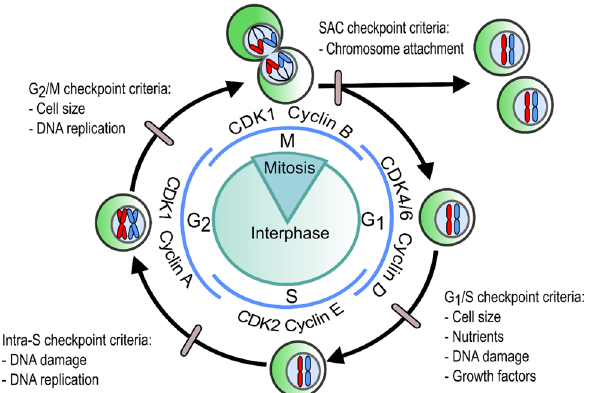
Figure 1. The generalised cell cycle in eumetazoans illustrating the cell-cycle phase and regulatory checkpoints (grey ovals) with their complementary criteria that must be met for the cell cycle to progress through that checkpoint. Blue lines depict the formation of cell-cycle phase associated CDK-cyclin complexes in Homo sapiens . SAC Spindle Assembly